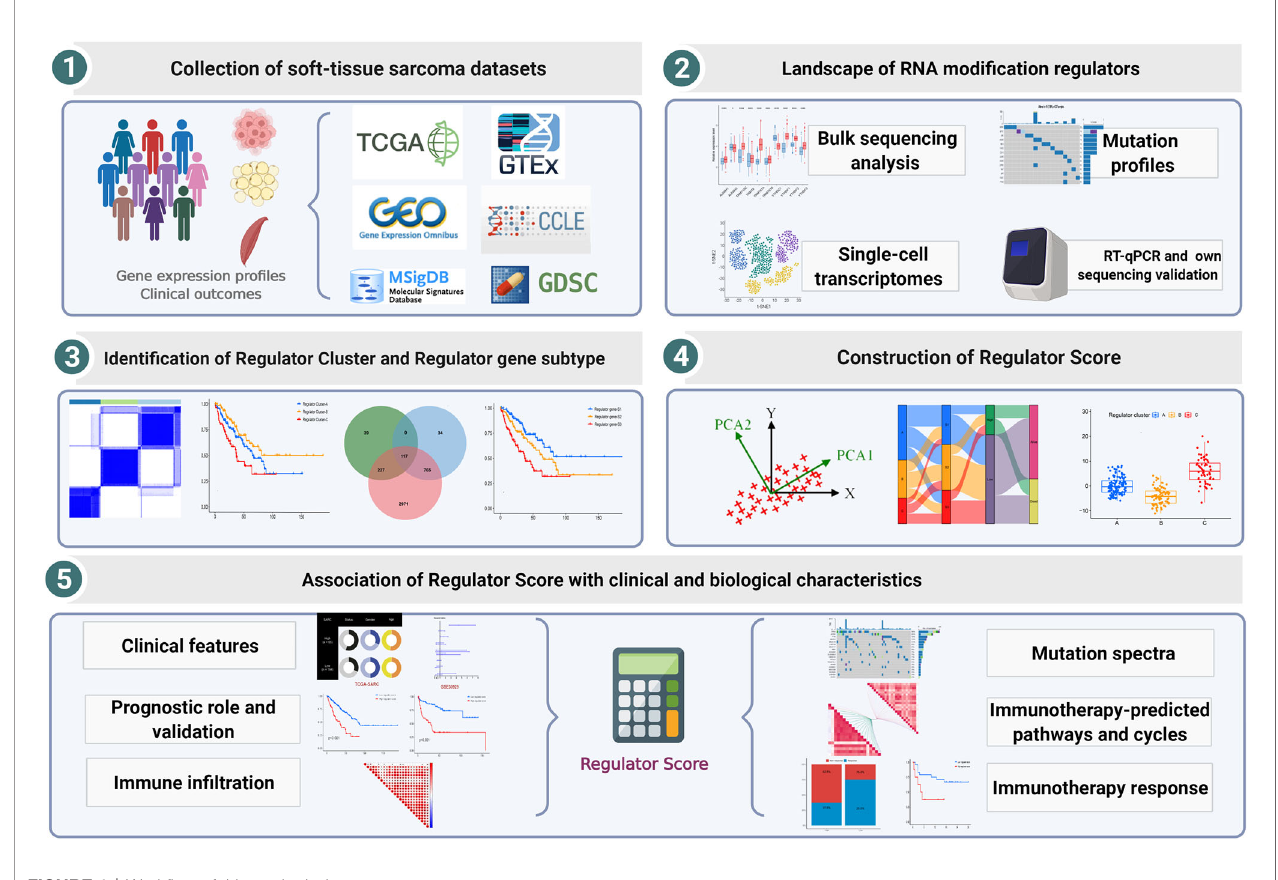
FIGURE 1 | Work fl ow of this study